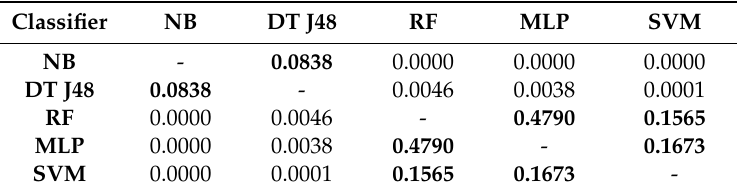
Table 2. P -values of Z -tests comparing Kappa indices between classifiers in a pairwise manner. The legend has nine classes. Bolded values indicate that the p -value is higher than α = 0.05.